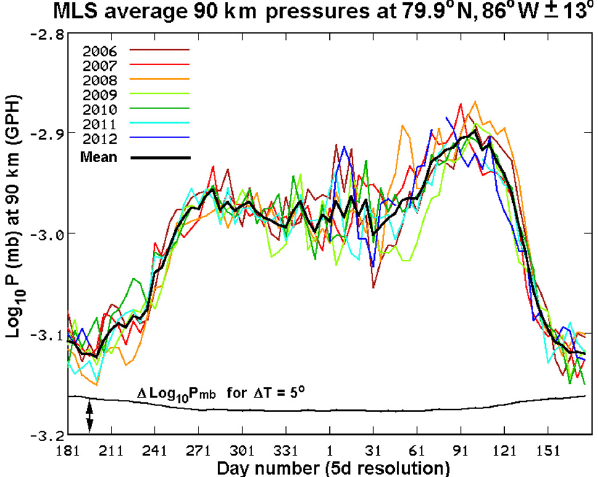
Fig. 5. Winter-centred 5 day average log 10 P (mb) at 90km (GPH) and latitude 79.9 ◦ N, longitude 86 ◦ ± 13 ◦ W: individual years and 7-year composite